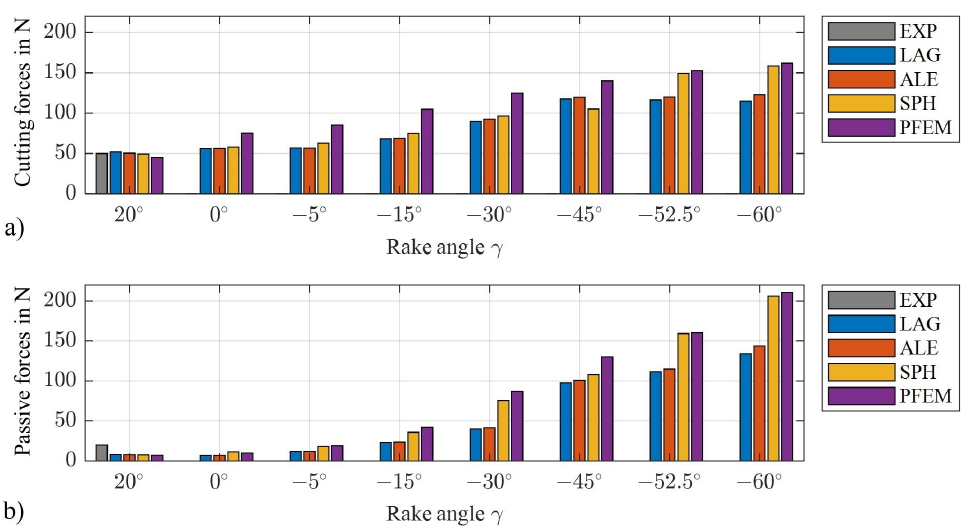
Figure 8. Cutting forces ( a ) and passive forces ( b ) of orthogonal cutting with discretization approaches LAG, ALE, SPH, and PFEM for tool rake angles 20 ◦ > γ > − 60 ◦ .